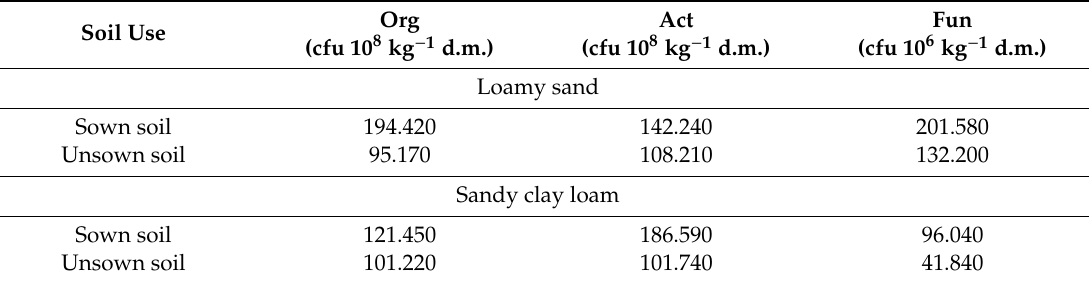
Table 5. The counts of microorganisms in non-contaminated soil. Soil